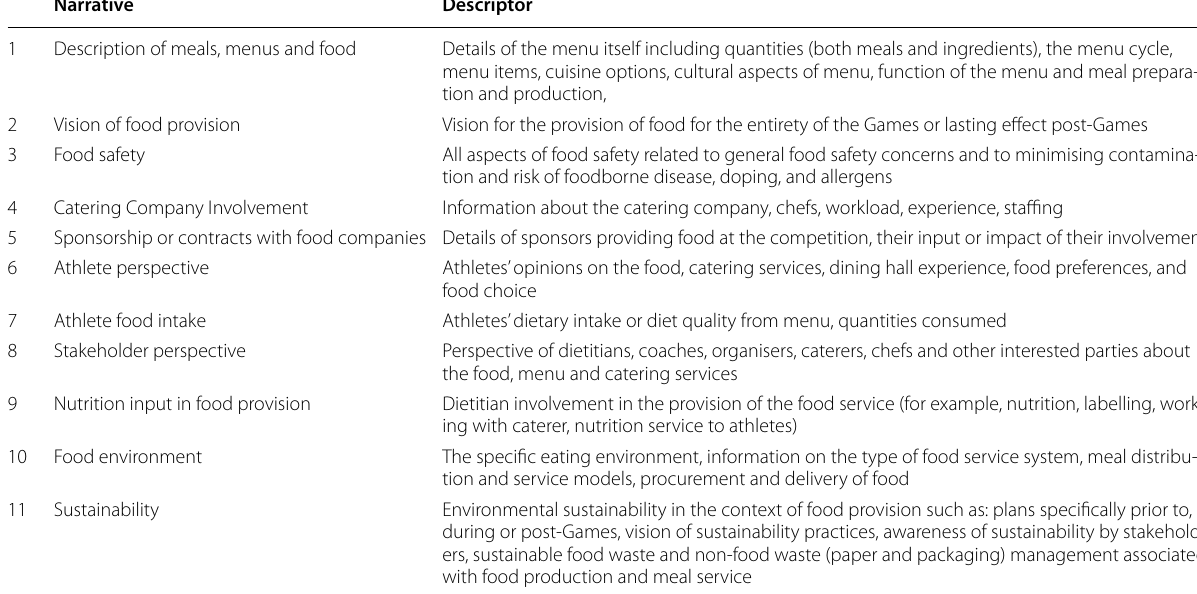
Table 1 Description of